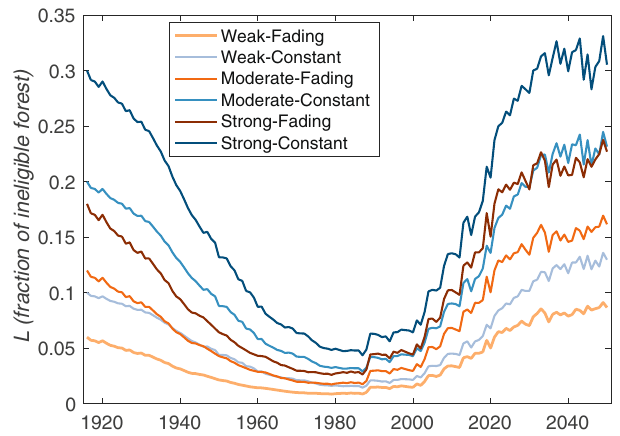
Fig. 4 Modeled fraction of forested land ( L ) ineligible to support forested burned area using various dynamic models. Forest- fi re area aggregated over the western US is derived from the estimated forest- fi re area from 1916 – 1983 25 and MTBS/MODIS records from 1984 to 2020. For 2021 – 2050, we show the median L from the 30 climate